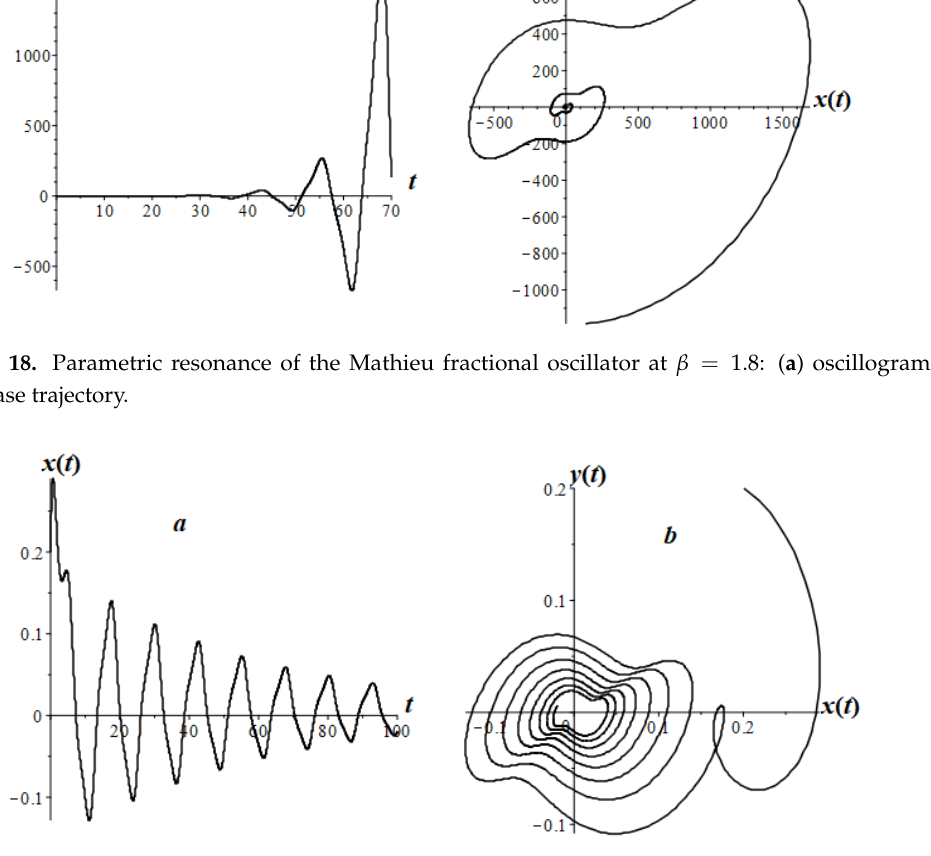
Figure 19. Damped mode of the Mathieu fractional oscillator: ( a ) oscillogram; ( b ) phase trajectory.